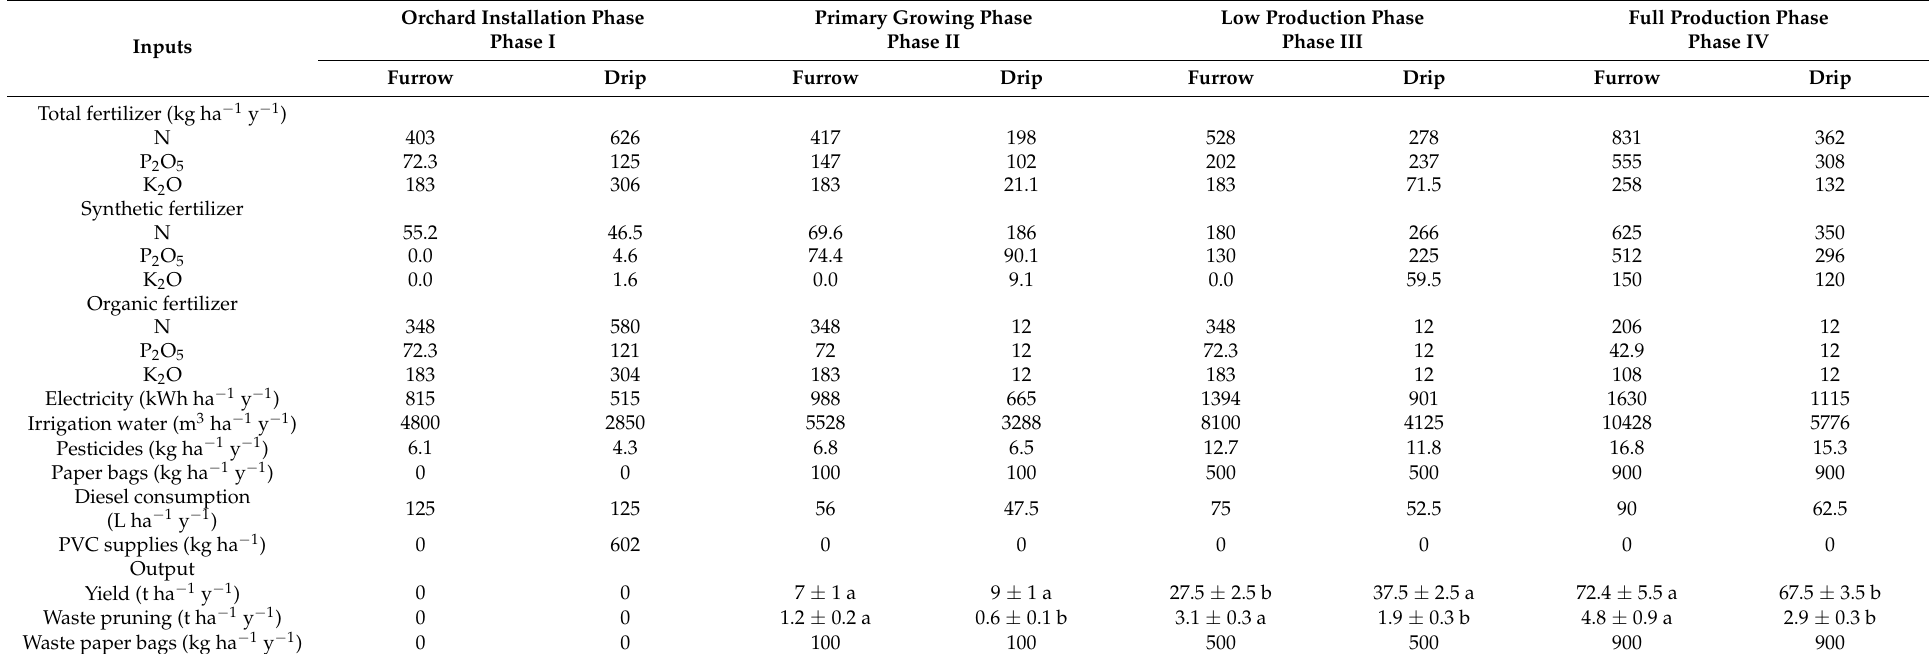
Table 1. Inventory data of furrow and drip irrigation pear orchards expressed as per hectare per year during the four growing phases. Fruit yield and waste pruning were expressed by means followed by different letters represent significant differences ( p < 0.05) between drip and furrow irrigated systems (a,